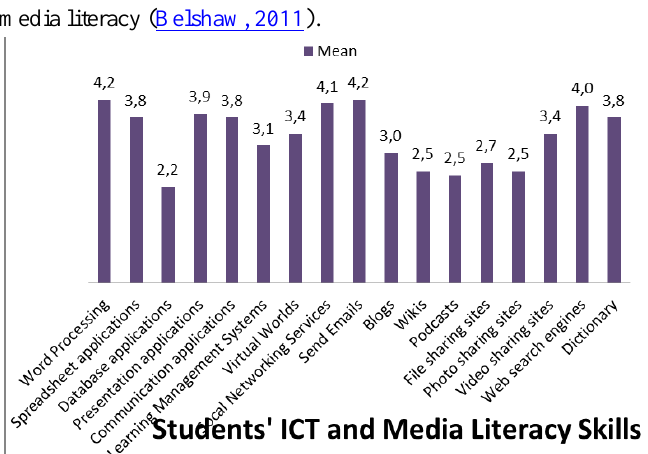
FIGURE 5 | Students’ ICT and Media Literacy